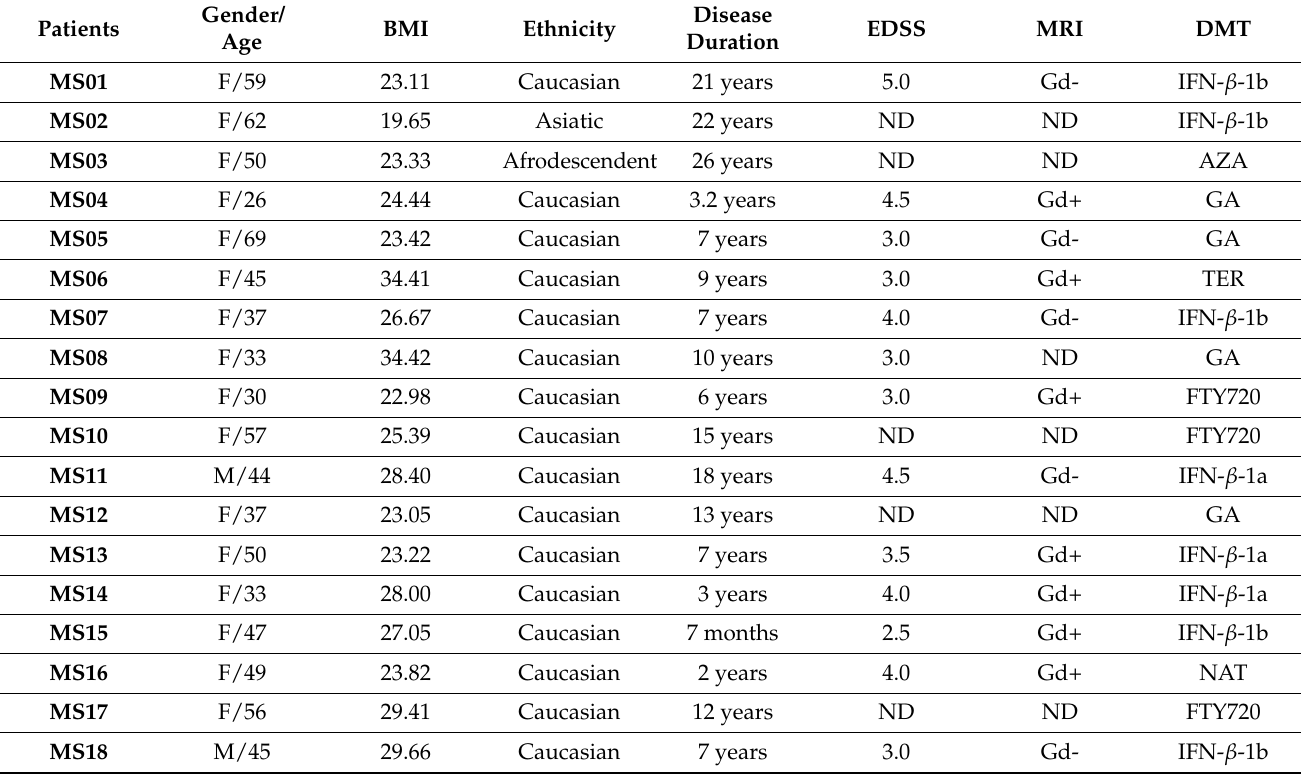
Table 1. Demographic and clinical data of the relapsing–remitting multiple sclerosis patients.